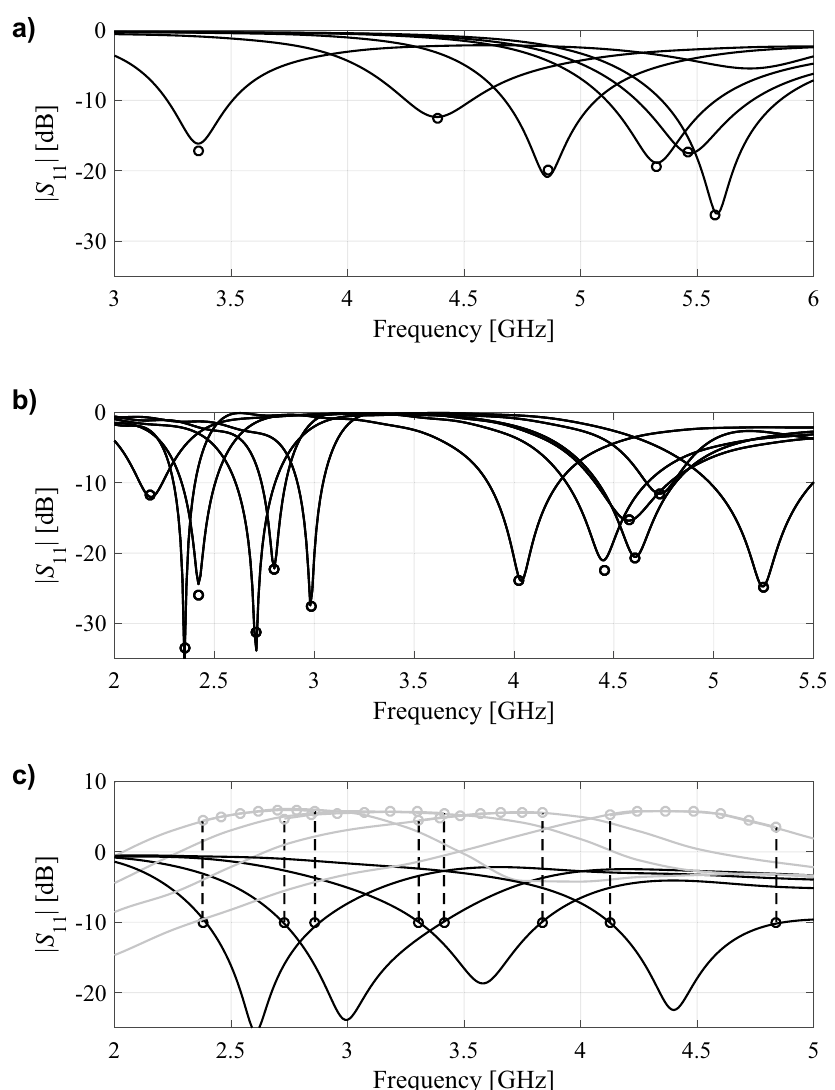
Figure 8. EM-simulated antenna responses at the selected test designs (—), along with the surrogate-predicted relevant antenna feature points (o); ( a ) ring-slot antenna of Fig. 4a (the operating frequency marked with circles), ( b ) dual-band antenna of Fig. 4b (the operating frequencies marked with circles), and ( c ) quasi- Yagi antenna of Fig. 4c (lower and upper frequencies corresponding to − 10 dB reflection levels, as well as corresponding values of the realized gain characteristic with five infill points are marked with circles). The surrogates set up using N = 200 training